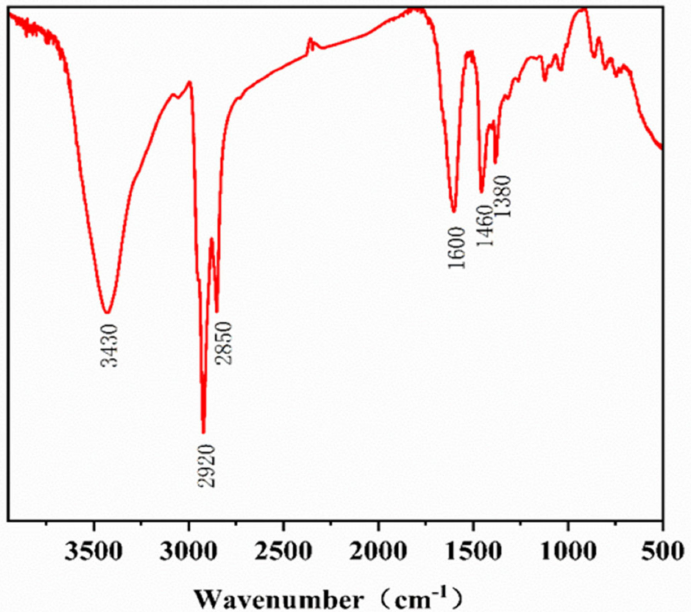
Figure 4. FT-IR spectra of the asphaltene isolated from African pipeline crude